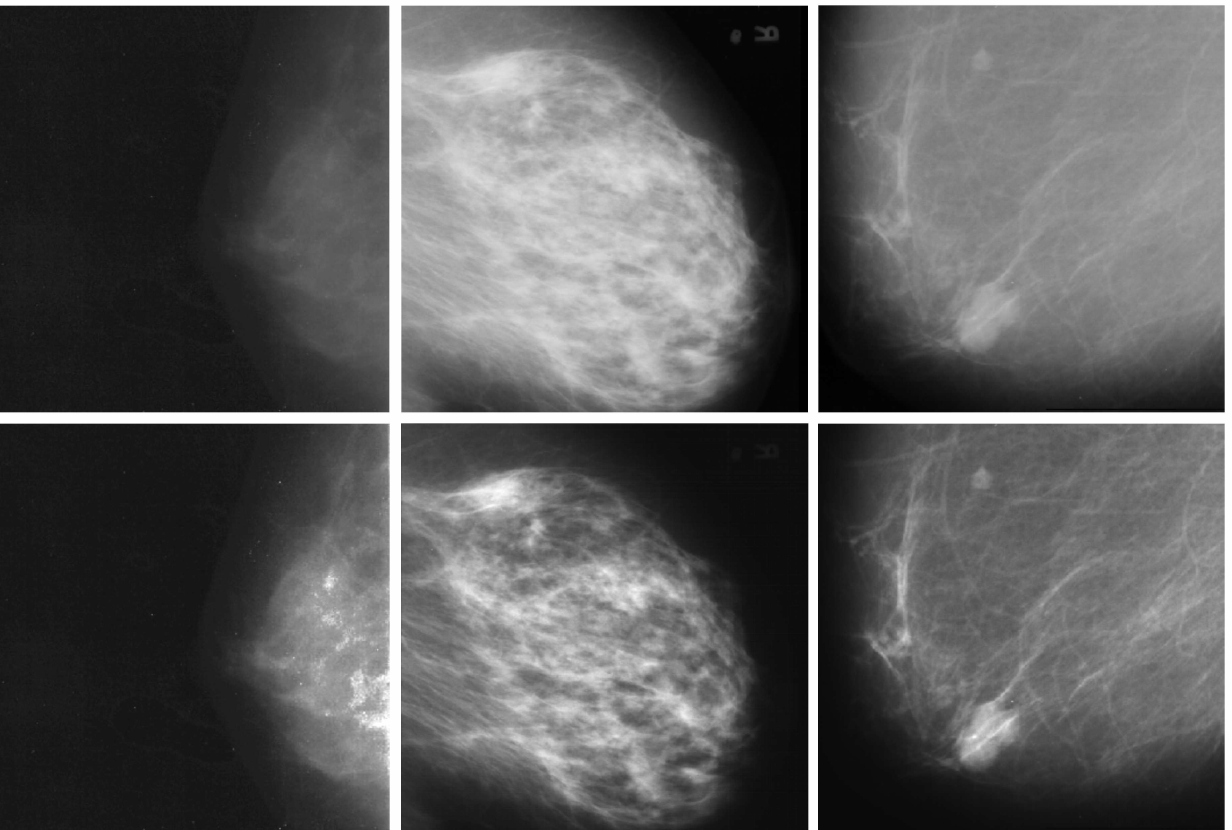
Figure 8. Full breast mammograms: Fundeni Hospital - normal breast (left), case mdb032, MIAS - benign ill-defined masses, fatty-glandular tissue (middle), case mdb005, MIAS - be- nign circumscribed masses - fatty tissue (right). Digitized X-ray images by optical scanning (top) and digitally restored images